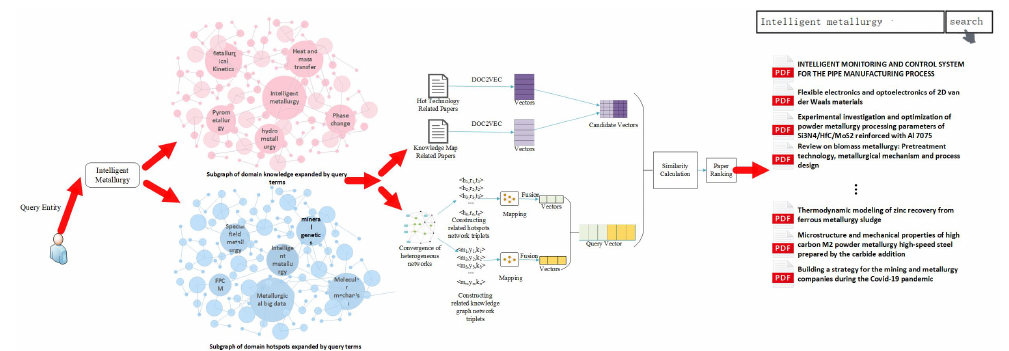
Figure 2. Example of literature recommendation